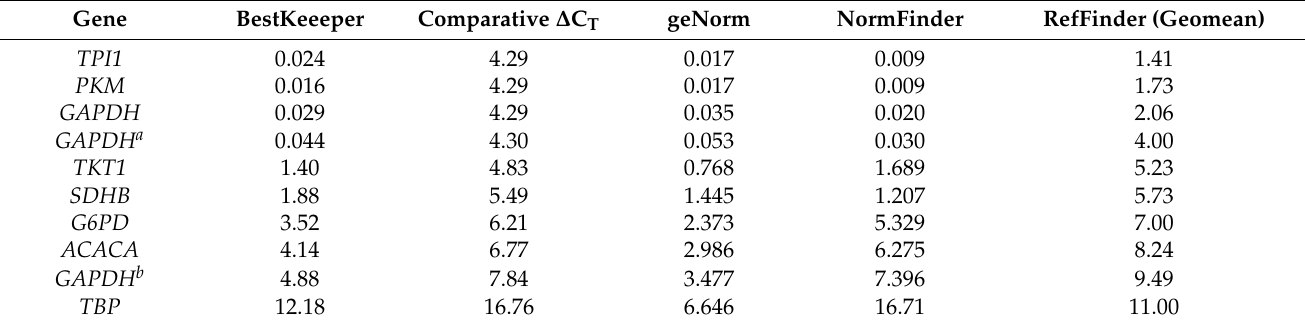
Table 4. Expression stability of the ten candidate reference genes analyzed in the HMC3 microglial cell line. Gene BestKeeeper Comparative ∆ C